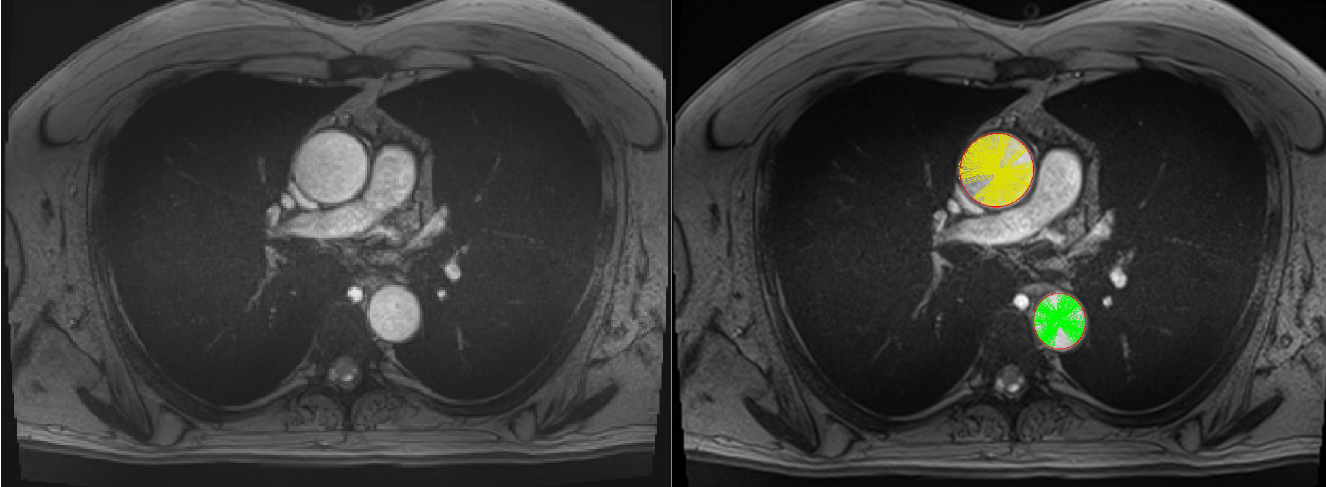
PLOS ONE | https://doi.org/10.1371/journal.pone.0256278 September 13,